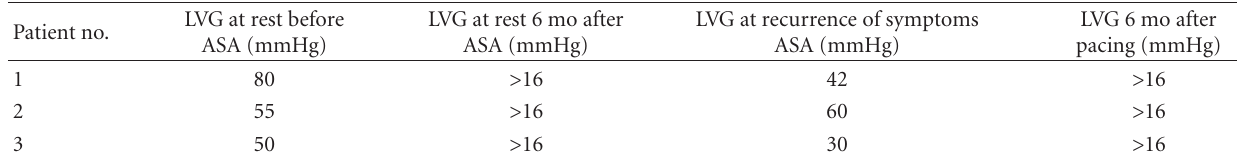
Figure 2: Patient N1 presented with syncope and 50 mmHg gradient at midcavity level 2 years after ASA. LV-gram before ASA (a) shows hyperkinetic LV and typical SAM (arrow). LV-gram at 26-month followup (b) is remarkable for the typical dumbbell shape in systole with formation of distal akinetic camera (thick arrow). Table 1: Dynamics of LVOTG as measured by